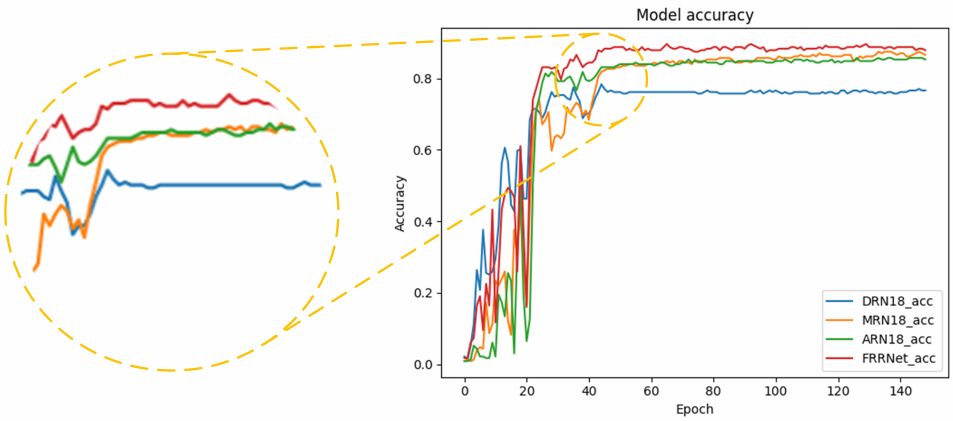
Figure 10. Network model training process demonstration in the CinC_2017 dataset: Comparison of accuracy convergence.